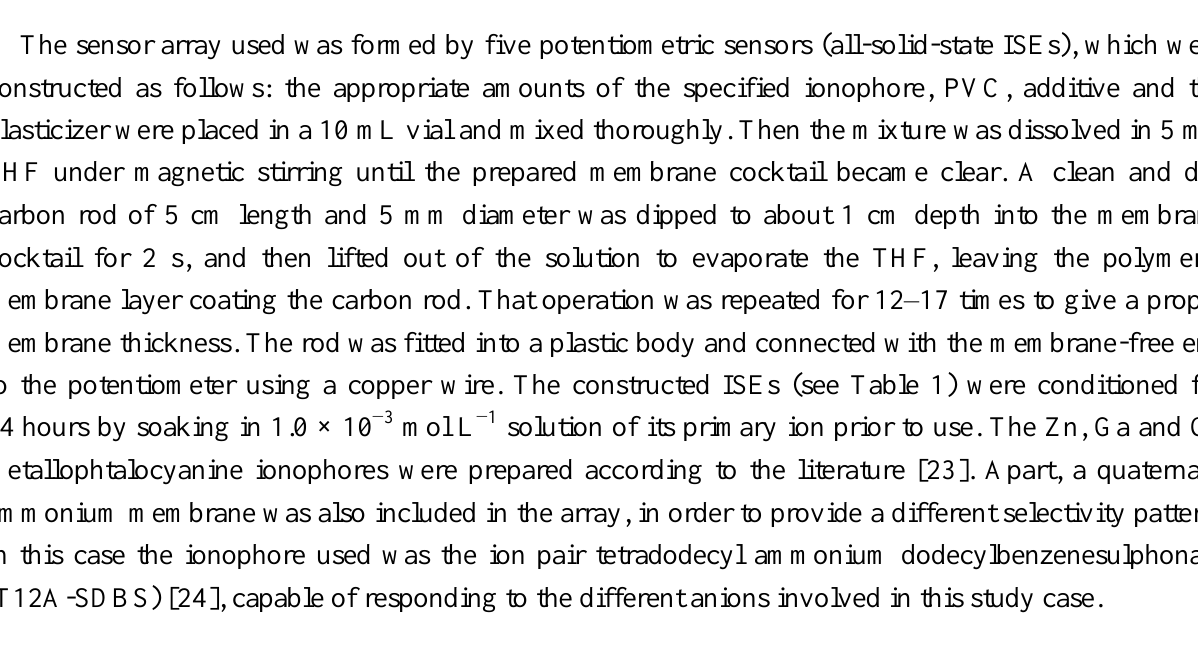
Table 1. Formulation of the ion-selective membranes employed in the construction of the potentiometric sensor